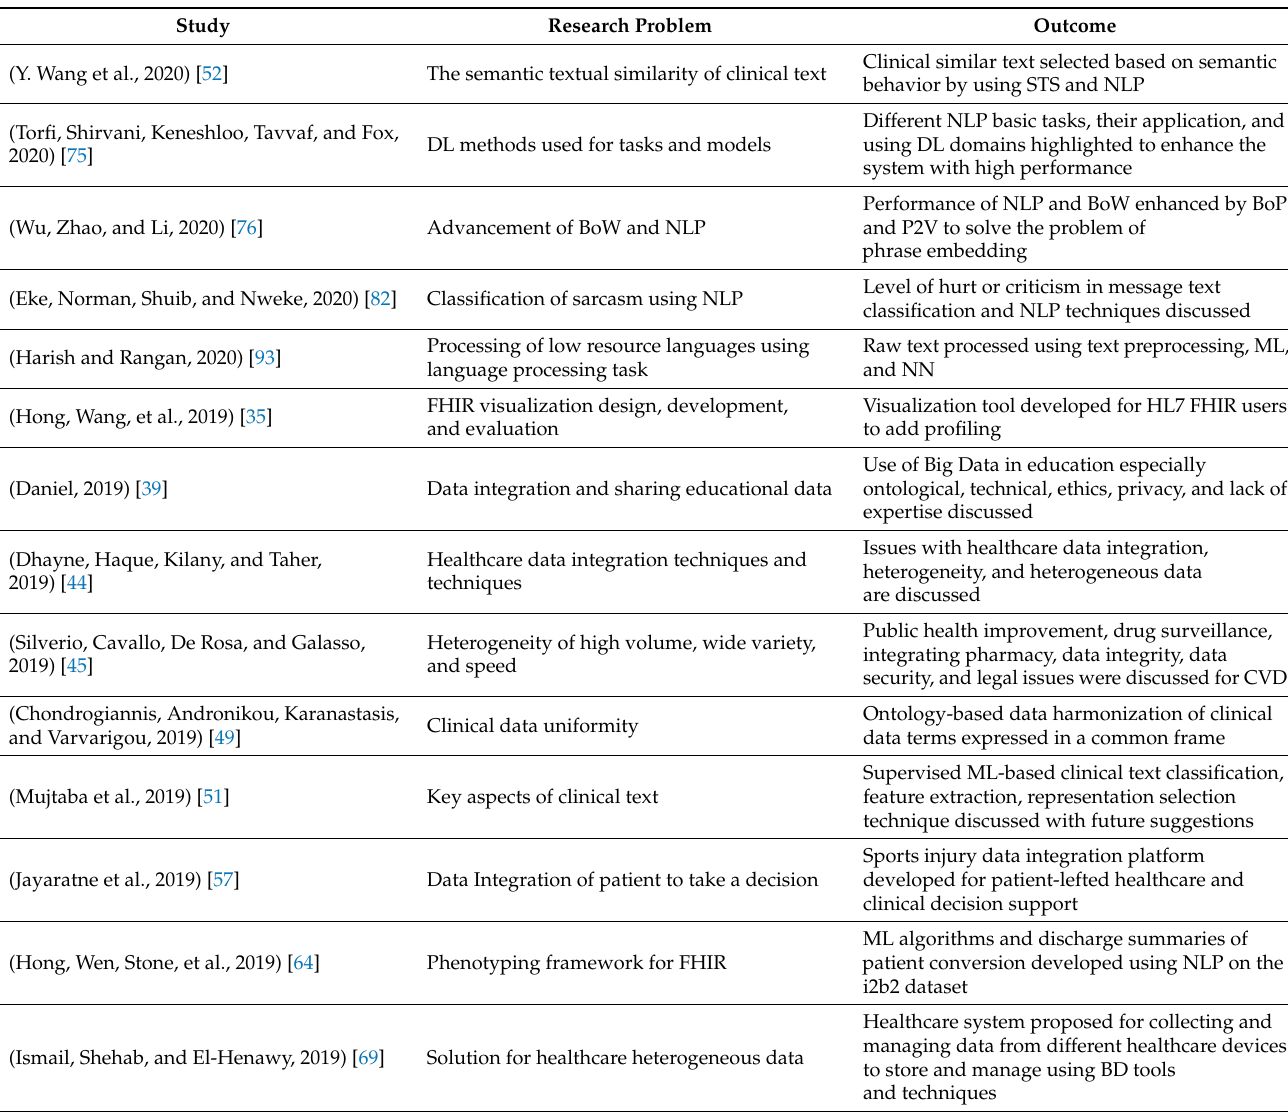
Table A1. Selected